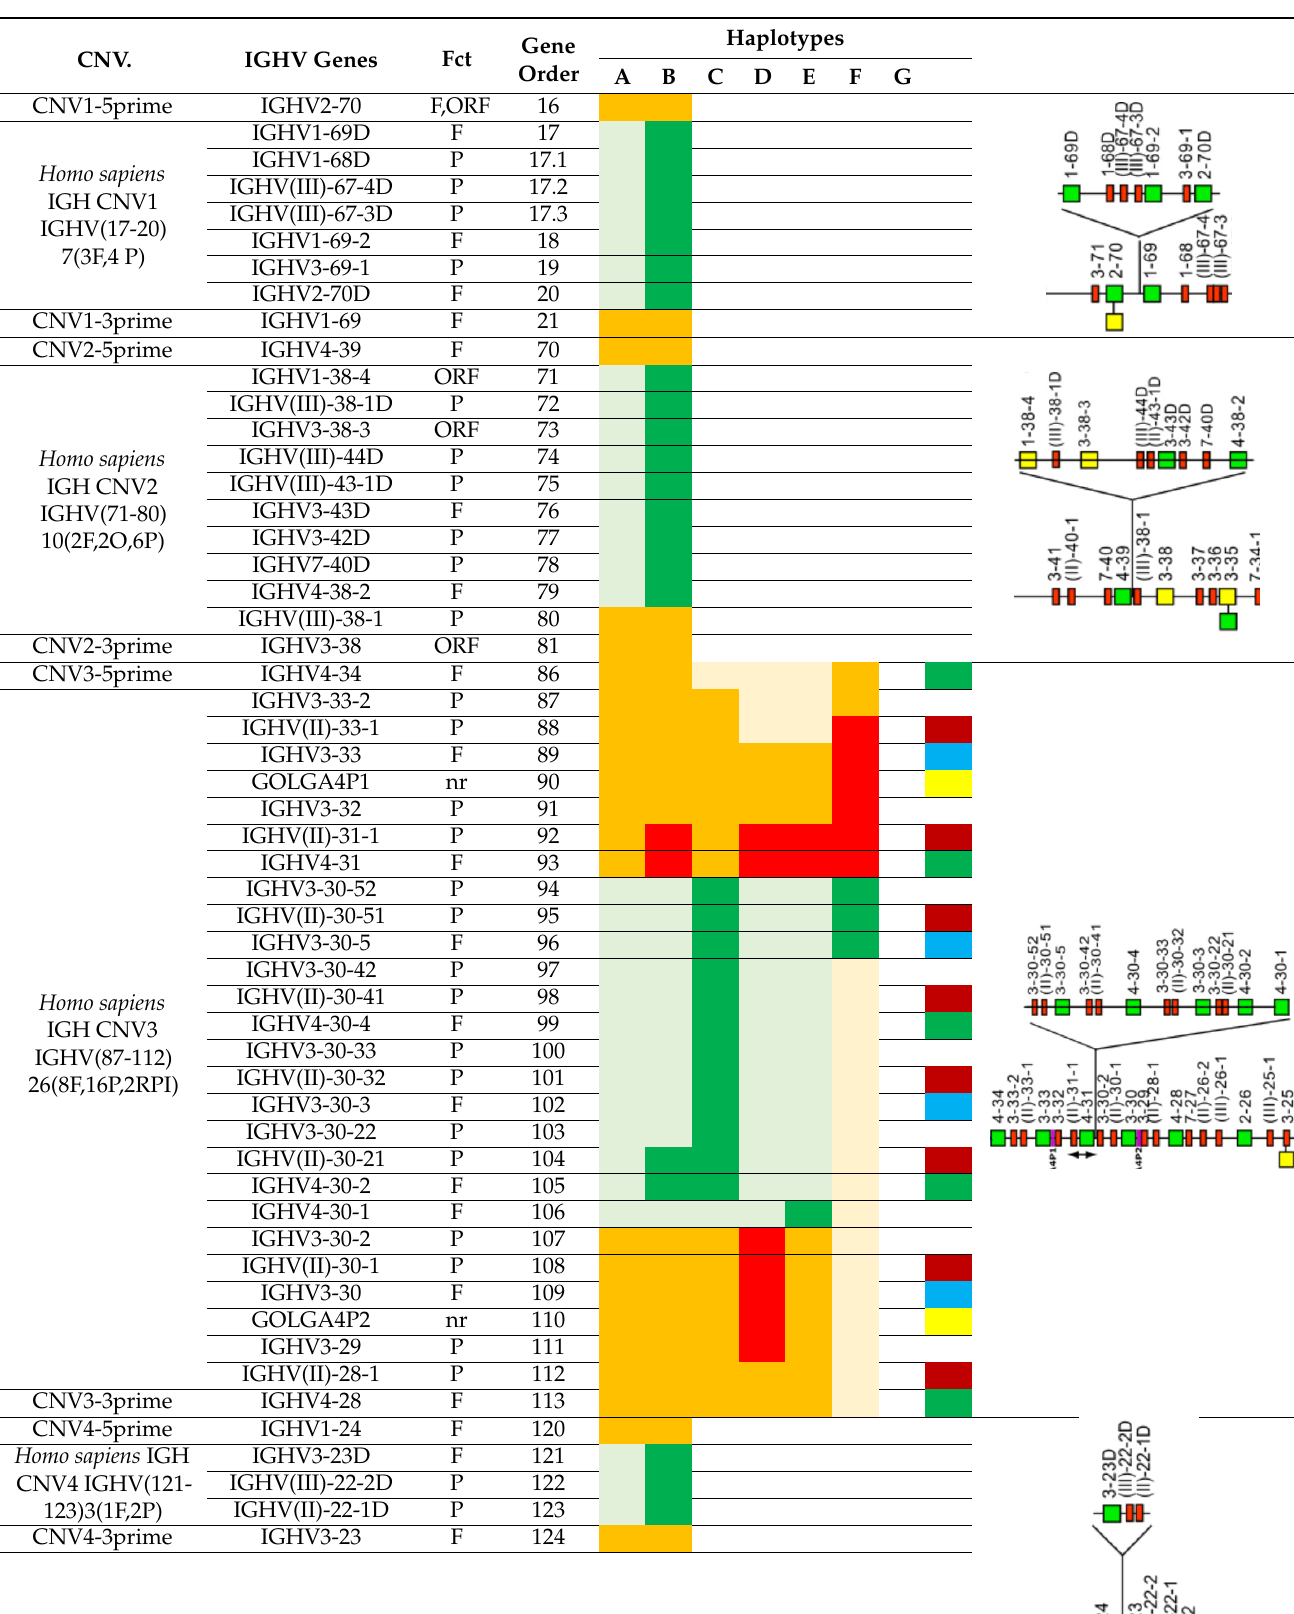
Table 4. Homo sapiens IGH locus CNV haplotypes.